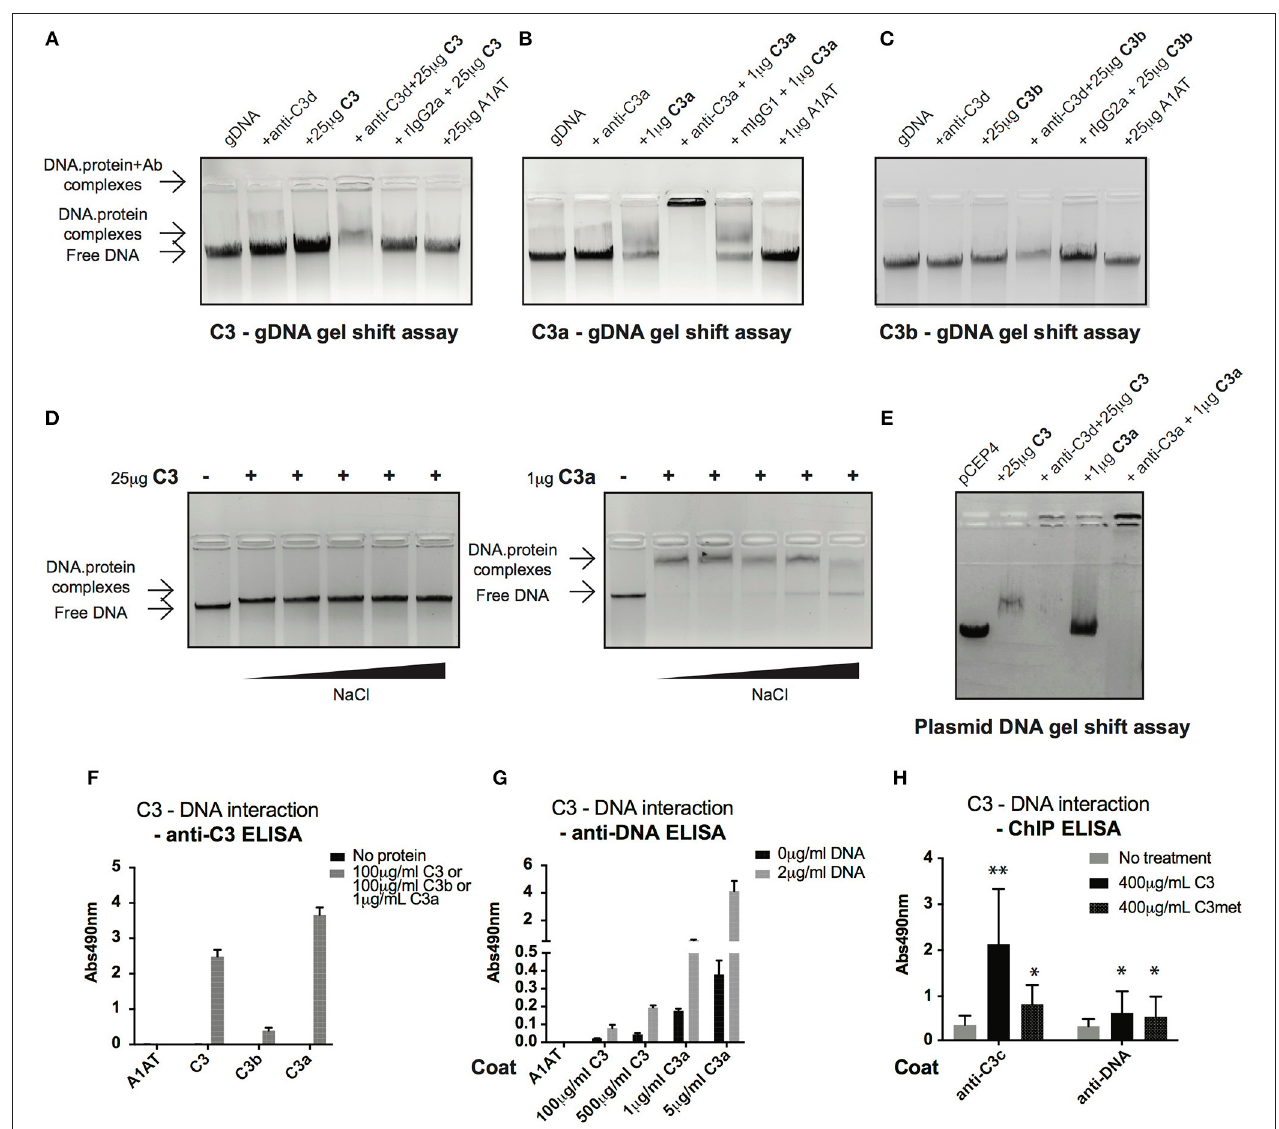
FIGURE 5 | C3 and C3a bind to distinct types of DNA. (A–C) Gel shift assays presenting interaction between C3(a) and genomic DNA isolated from Raji cells. Isolated genomic DNA was incubated either with pre-titrated concentrations of C3 (A) or C3a (B) or C3b (C) and separated by agarose gel electrophoresis. Formation of high molecular weight DNA-protein complexes is indicated by slower DNA migration (DNA shift) compared to migration of the free nucleic acid. The presence of C3 and its cleavage fragments in the pre-formed protein-DNA complexes was confirmed with anti-C3a and anti-C3d antibodies caused supershift. One representative experiment out of five performed is shown. (D) Gel shift assays showing that C3(a)—DNA interaction is not ionic in nature. C3 or C3a were incubated with genomic DNA of Raji cells in the presence of increasing NaCl concentration (ranging from 150 to 1,200mM). Binding of C3 and C3a to DNA was observed at 8X higher salt concentration than the physiological 150mM. (E) Interaction of C3 and C3a with DNA is not restricted to genomic DNA. Linearized pCEP4 vector was incubated with either C3 or C3a and DNA-protein complex formation was investigated by gel shift assay. Results illustrated are one representative out of three independent experiments. (F,G) ELISA results confirming interaction between C3(a) and DNA. ELISA microplate surfaces were coated either with DNA (F) or C3, C3a, C3b (G) . After incubation with distinct concentrations of C3 proteins (F) or Raji genomic DNA (G) , protein-DNA interactions were detected using anti-C3d, anti-C3a (anti-C3 ELISA, F ), or anti-dsDNA antibody (anti-DNA ELISA, G ). Results shown are mean absorbance values measured at 490nm with SD of four independent experiments. (H) ELISA results showing presence of C3-DNA complexes in formaldehyde cross-linked chromatin fraction of Raji B cells. Cells were incubated in the presence or absence of C3, C3met, fixed with 1% formaldehyde to cross-link protein-DNA complexes and chromatin isolated using commercial kit. C3-DNA complexes were investigated by ELISA on anti-C3 or anti-DNA coated plates. Data are shown as mean absorbance values measured at 490nm with SD of three independent experiments. Differences with p < 0.05 were considered statistically significant and compared to non-treated cells (two-way ANOVA with Dunnett’s multiple comparison, ns p > 0.05, * p < 0.05, ** p < 0.01).